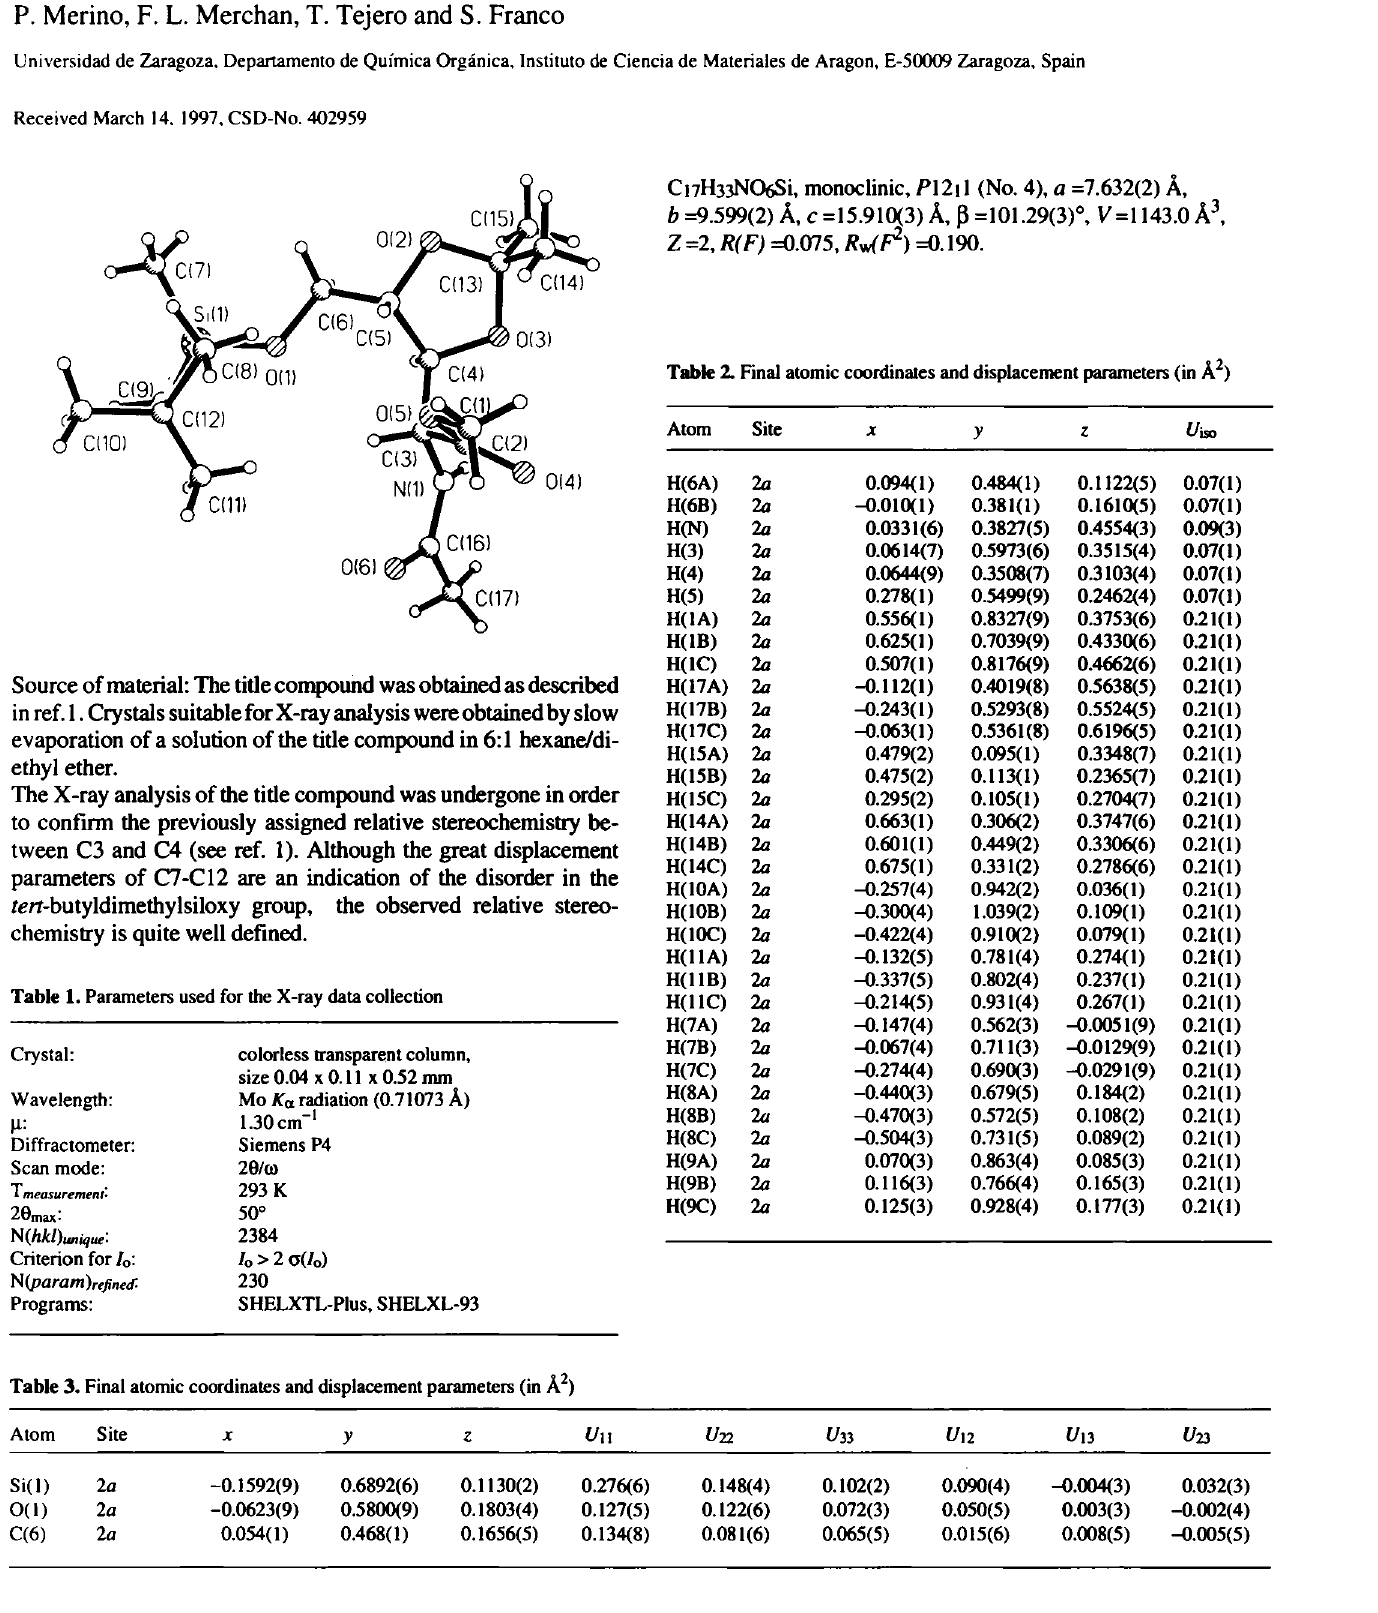
Table 2. Final atomic coordinates and displacement parameters (in A^)